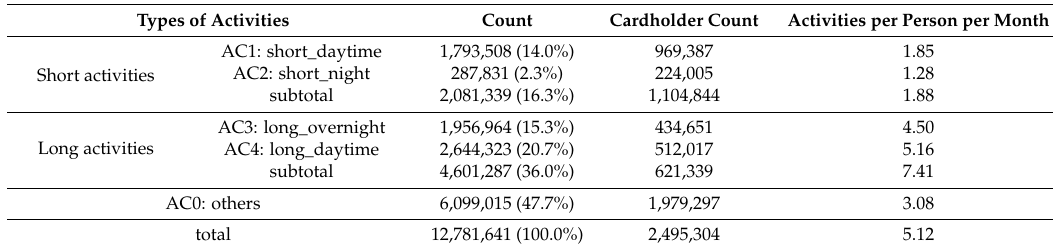
Figure 5. ( a ) How the number of clusters changes with N τ ; ( b ) the cluster results of DBSCAN. Table 2. Statistics of five cluster activities.